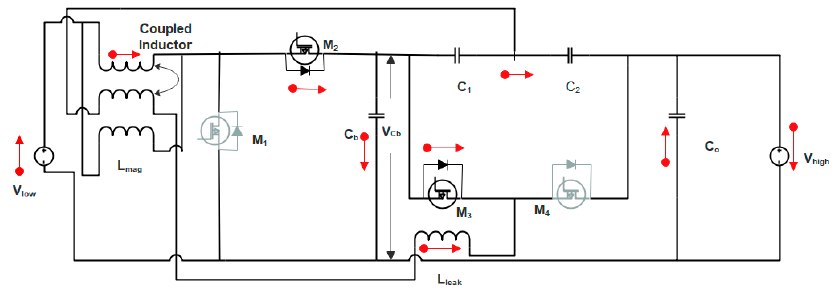
Figure 8. Equivalent circuit for mode VI.